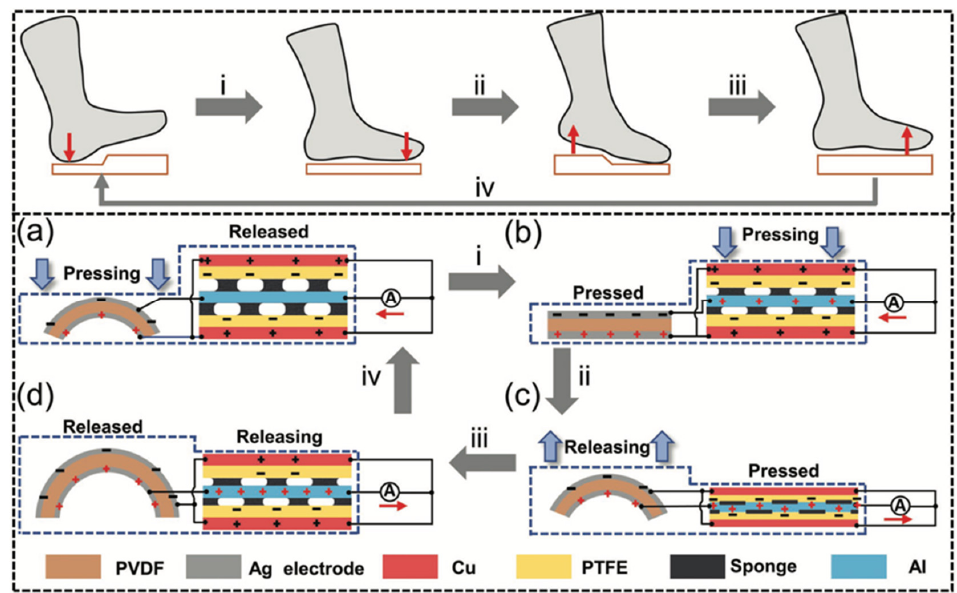
Figure 13. Working mechanisms of the PENG and TENG parts of the IHN during one walking cycle [109]. Schematic of the charge transfer process of the PENG and TENG parts when ( a ) the hindfoot falls, ( b ) the forefoot falls, ( c ) the hindfoot lifts, and ( d ) the forefoot lifts, respectively. Reprinted with permission from [109]. Copyright 2022, John Wiley and Sons.